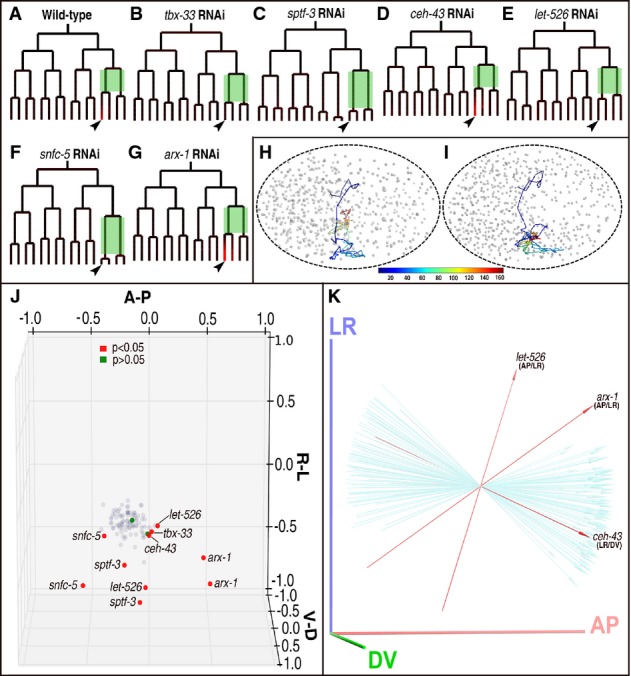
Roles of temporally relevant genes in regulation of fate specification and cell migration using excretory cell precursor as an example

A–G Lineal expression of CEH-26 (depicted in red) in wild-type (A) and RNAi (B–G) embryos with genotypes indicated on the top. All trees are rooted with ABplpa. The arrowheads indicate ABplpappaa, that is, the mother of excretory cell. Two sister cells used for calculation of ADS are shaded in green. Note the abolishment of CEH-26 expression by RNAi against tbx-33, sptf-3, let-526, and snfc-5 but not by RNAi against ceh-43 and arx-1.

H, I 4D trajectories showing migration of the excretory cell precursor starting from ABp up to its final differentiation into ABplpappaap at approximately 550-cell stage for a wild-type and let-526 RNAi embryos, respectively. Shown are the ventral views of the embryos with anterior to the left. The cell migration path is depicted starting from the last time point of ABa so that it changes color with accumulative developing time. Color coding of the time scale in minutes is shown at the bottom.

J The relative positions of ABplpappa at its last time point (approximately 350-cell stage) for wild-type (gray dots) and perturbed embryos (green or red dots with gene name indicated) with two replicates each. Green and red dots denote deviations from wild-type distribution with P > 0.05 and P < 0.05, respectively (see Materials and Methods). Embryos are shown with anterior to the left and right to the top. A-P, L-R, and D-V depict anterior–posterior, left–right, and dorsal–ventral axes respectively. Dot is not drawn to scale in size.

K Shown are division angles of 91 wild-type (light blue) and three perturbed embryos with genes indicated (red). Division angles are calculated as that between the division orientation of ABplpappa relative to the three planes defined by axes between AP/LR, AP/DV, and LR/DV. Only division angles that are significantly deviated from wild type upon perturbation are shown. The reference plane for calculation of the angle deviation is indicated below gene name. Embryo axes are defined in the same way as that in (J).